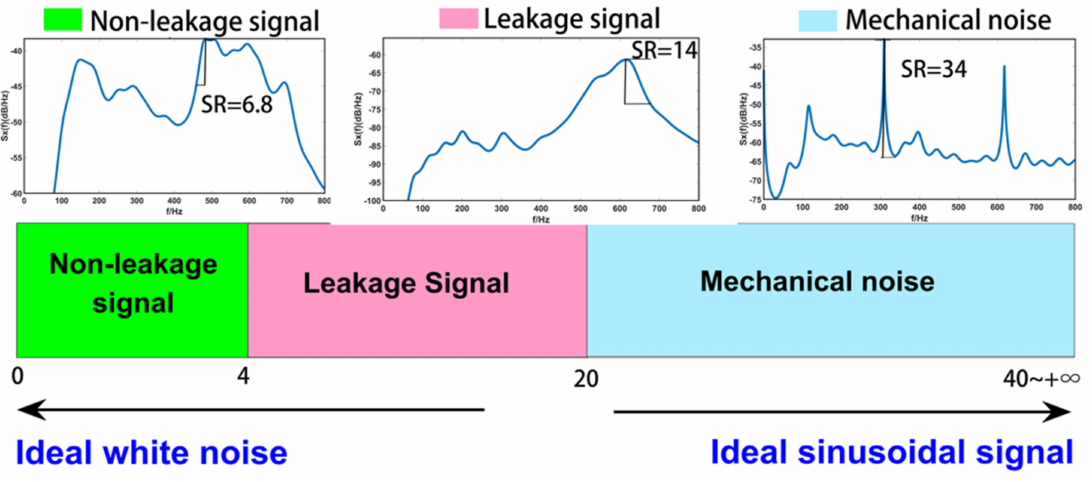
Figure 2. Classification standard for the roll-off rate of leakage